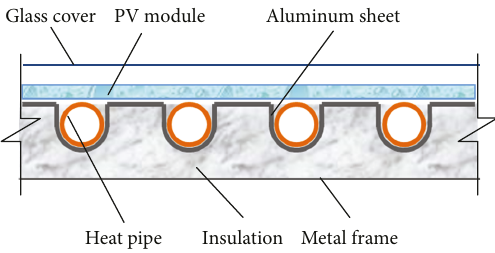
Figure 2: Cross-sectional view of heat pipe PV/T